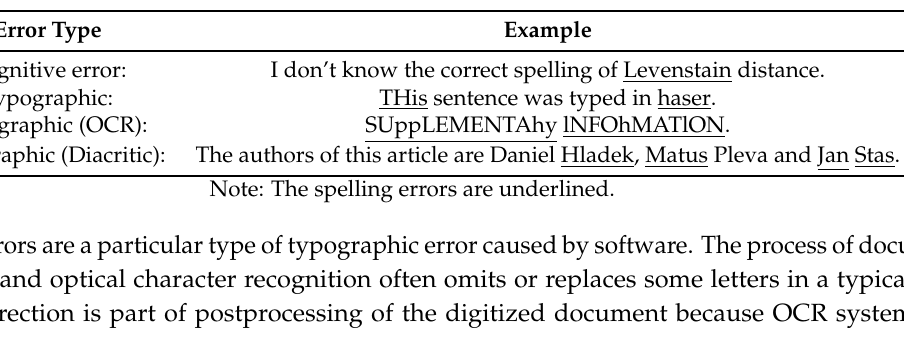
Table 1. Examples of cognitive and typographic